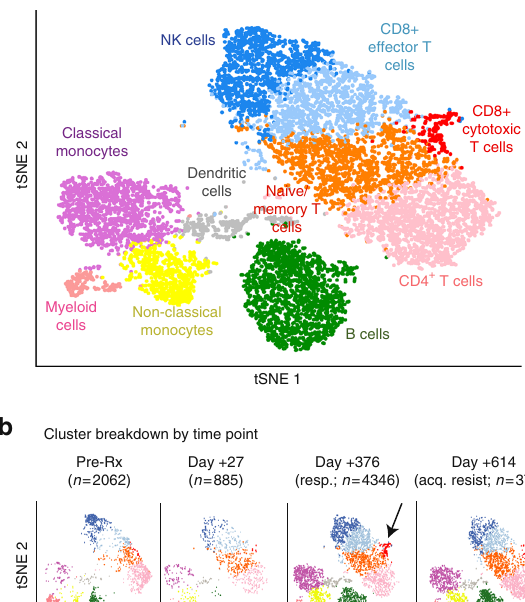
Fig. 2 scRNAseq of PBMC identi fi es an activated CD8 + T cell population at response. Four peripheral blood time points are shown, all from the discovery patient (2586-4): pre-treatment, early post-treatment (day + 27), treatment response (day + 376), and late/acquired resistance (day + 614). a t-Stochastic Neighbor Embedding (tSNE) visualization of clustering of peripheral blood. Peripheral blood mononuclear cells (PBMC; n =